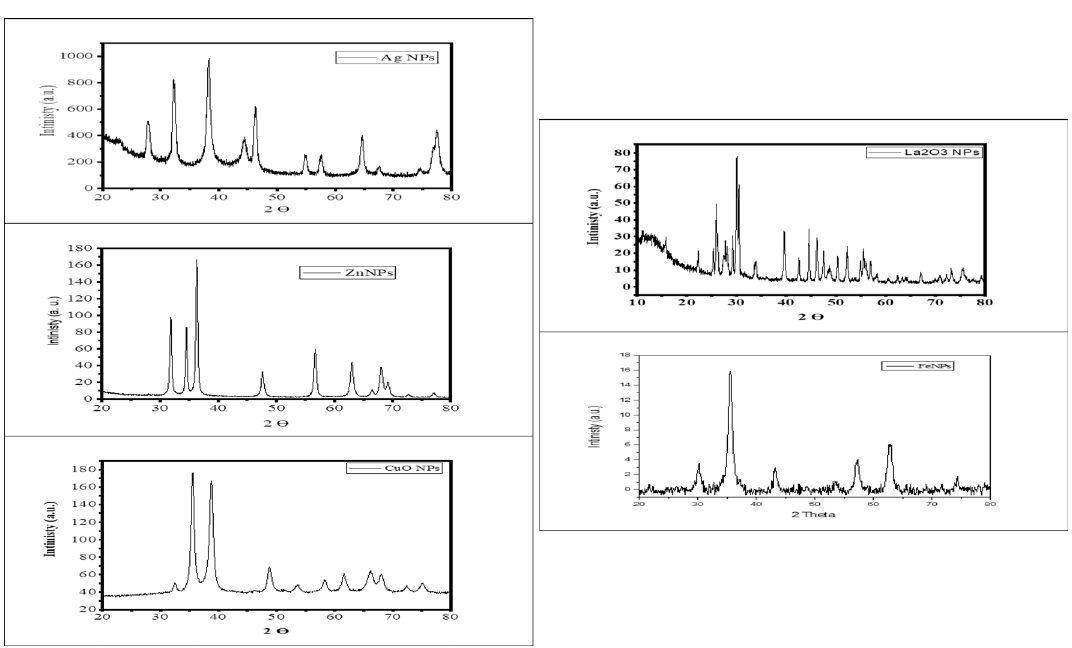
Figure 3. X-ray diffraction pattern of various metal nanoparticles from aqueous extract of M.